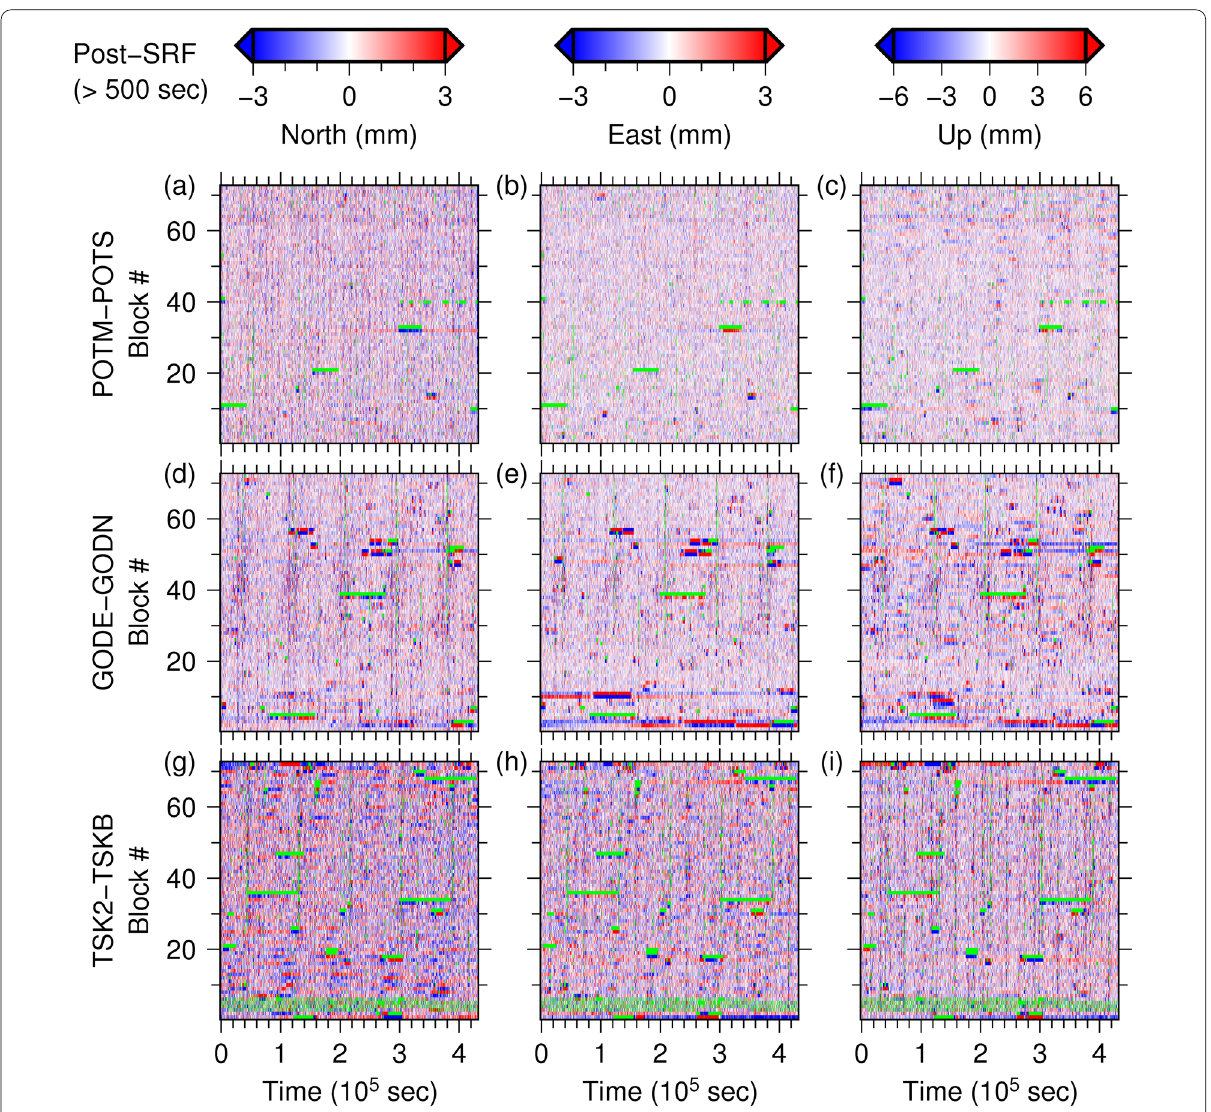
Fig. 5 Coordinate fluctuation of three baselines as labeled in each block after sidereal filtering (SRF). The sidereal filter is made of each succeeding block. Low-pass filtering (LPF) with a cut-off period of 500 s is applied to coordinates used as sidereal filter. Left ( a , d , and g ), center ( b , e , and h ), and right ( c , f , and i ) columns indicate north, east, and up components, respectively. Green color represents epochs filled by interpolation of neighboring epochs during the data cleaning process. The same plots but using a different sidereal filter are provided in Additional file 2: Figs. S9, S11, S12, S13, S14, and